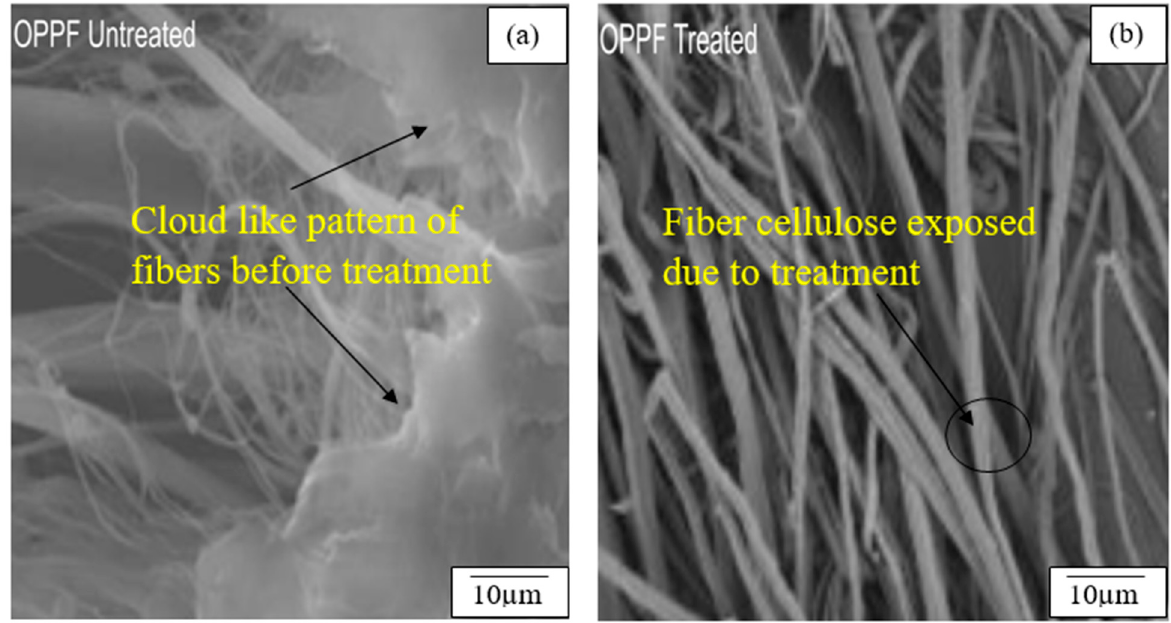
Figure 4. SEM Image of ( a ) Untreated OPPF Fiber ( b ) Treated OPPF Fiber.